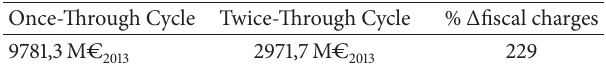
Table 3: Total taxes obtained for period 2013–2028 in each fuel management